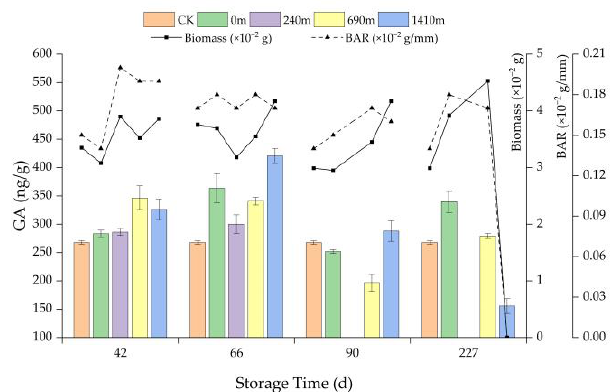
Figure 6. Variation of GA content of rape seeds stored in deep underground with storage duration and depth. The bar graph showed the change of GA content, the solid line in the line graph showed the change of biomass, and the dashed line showed the change of BAR.